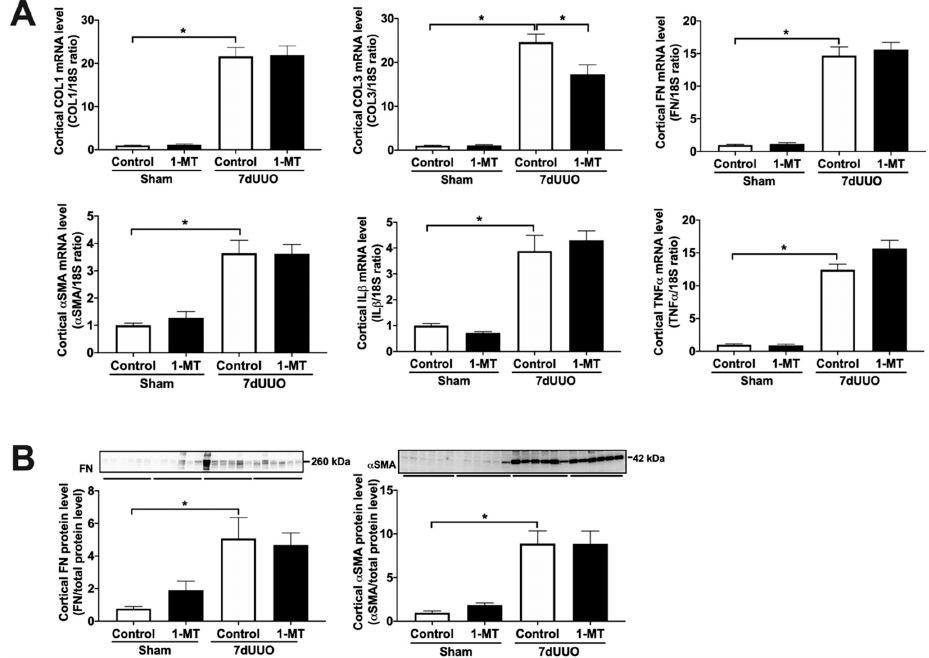
Figure 3. Cortical IDO protein expression increases following UUO. Mice were subjected to 7 days of unilateral ureteral obstruction (UUO). Afterward, indoleamine 2,3-dioxygenase (IDO) protein ex- pression was studied using western blot (n = 8–10). Data are presented as mean ± SEM. * p < 0.05.